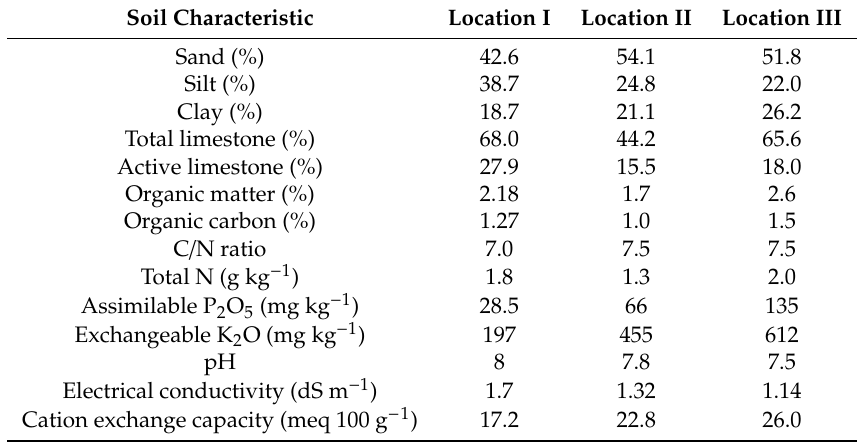
Table 1. Soil physio-chemical characteristics ( − 30 cm depth) of the three locations under